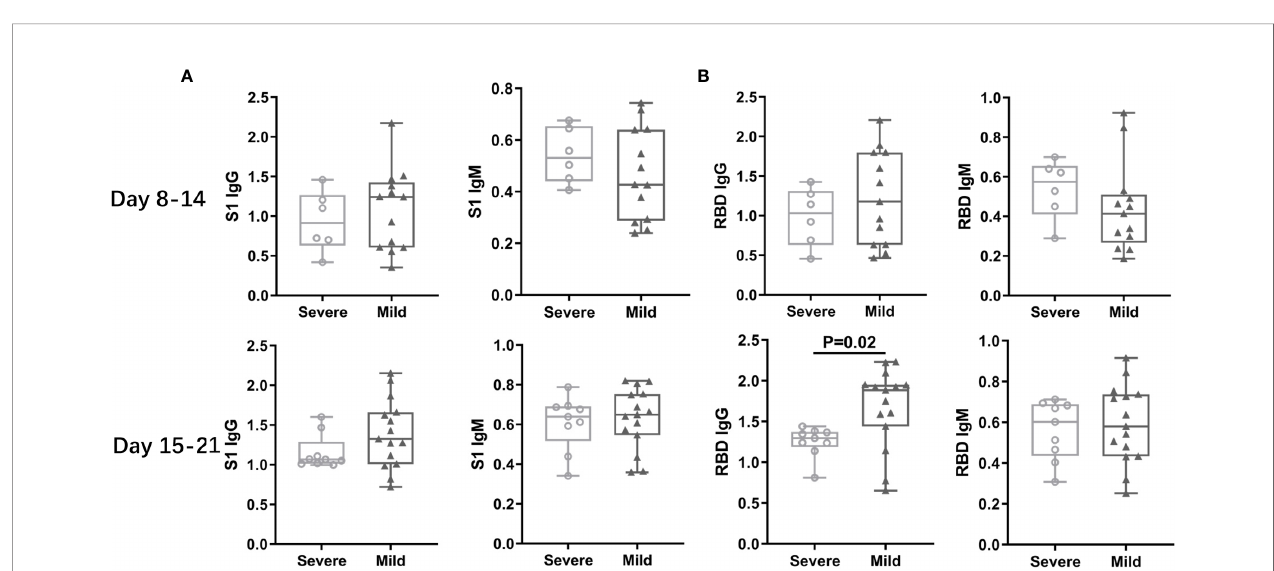
FIGURE 3 | Patients with Mild Symptoms Had Higher Level IgG after Two Weeks from Onset. The patients were grouped by disease symptom. The titers of IgG and IgM antibody against S1 protein (A) or RBD (B) between 8-21 days from symptom onset were collected and analyzed.